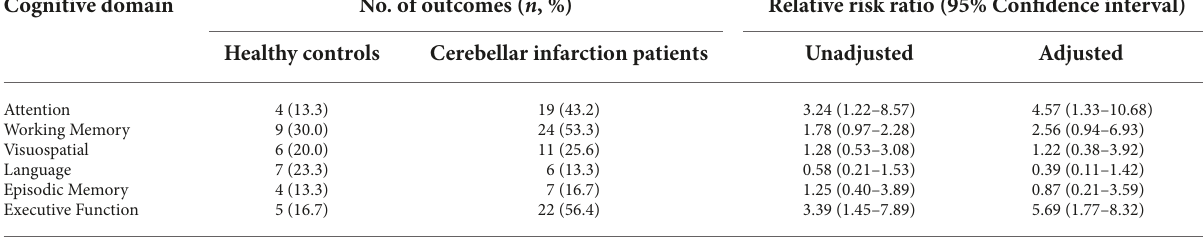
TABLE 3 Relative risk ratio for each impaired cognitive domain among healthy controls and patients with cerebellar infarction. Cognitive domain No. of outcomes ( n , %) Relative risk ratio (95% Confidence interval) Healthy controls Cerebellar infarction patients Unadjusted